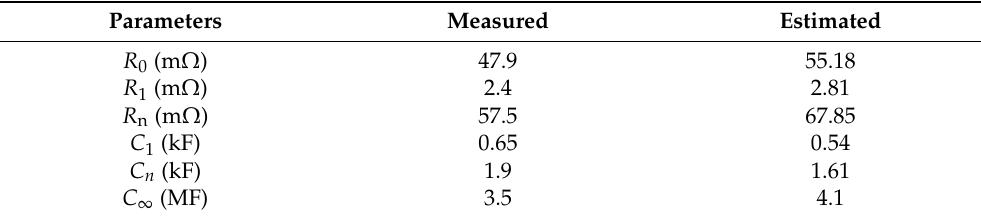
Table 8. Results of Case 1.